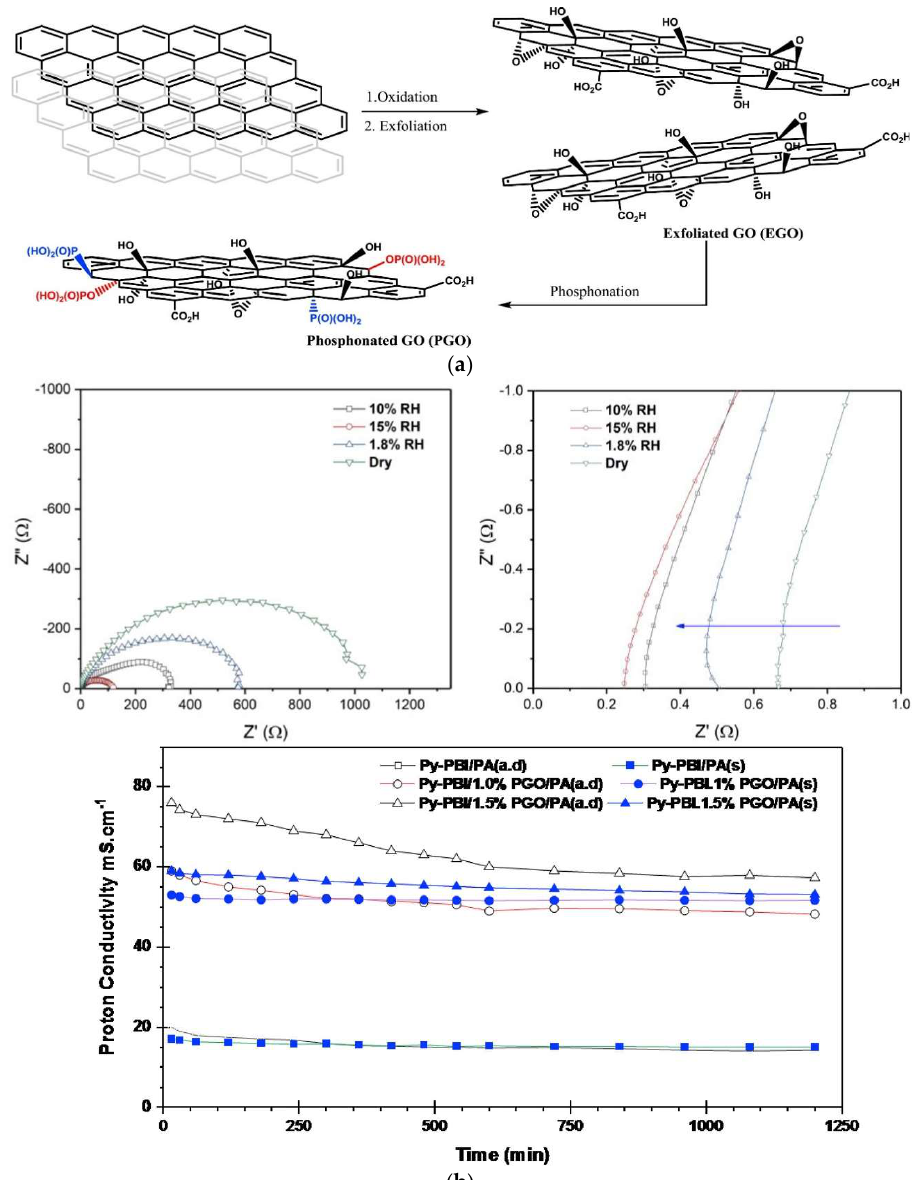
Figure 16. Preparation of functionalized graphene oxide ( a ); Nyquist plot of H 3 PO 4 -doped py-PBI/1.5 wt.% pGO under various RH at 120 °C; zoom-in in the high frequency intercept; and proton conductivity of the py-PBI composite membranes with different filler content as a function of testing time at 140 °C and 0% RH ( b ). Reprinted with permission from Ref. [136]. Copyright 2019 Elsevier.